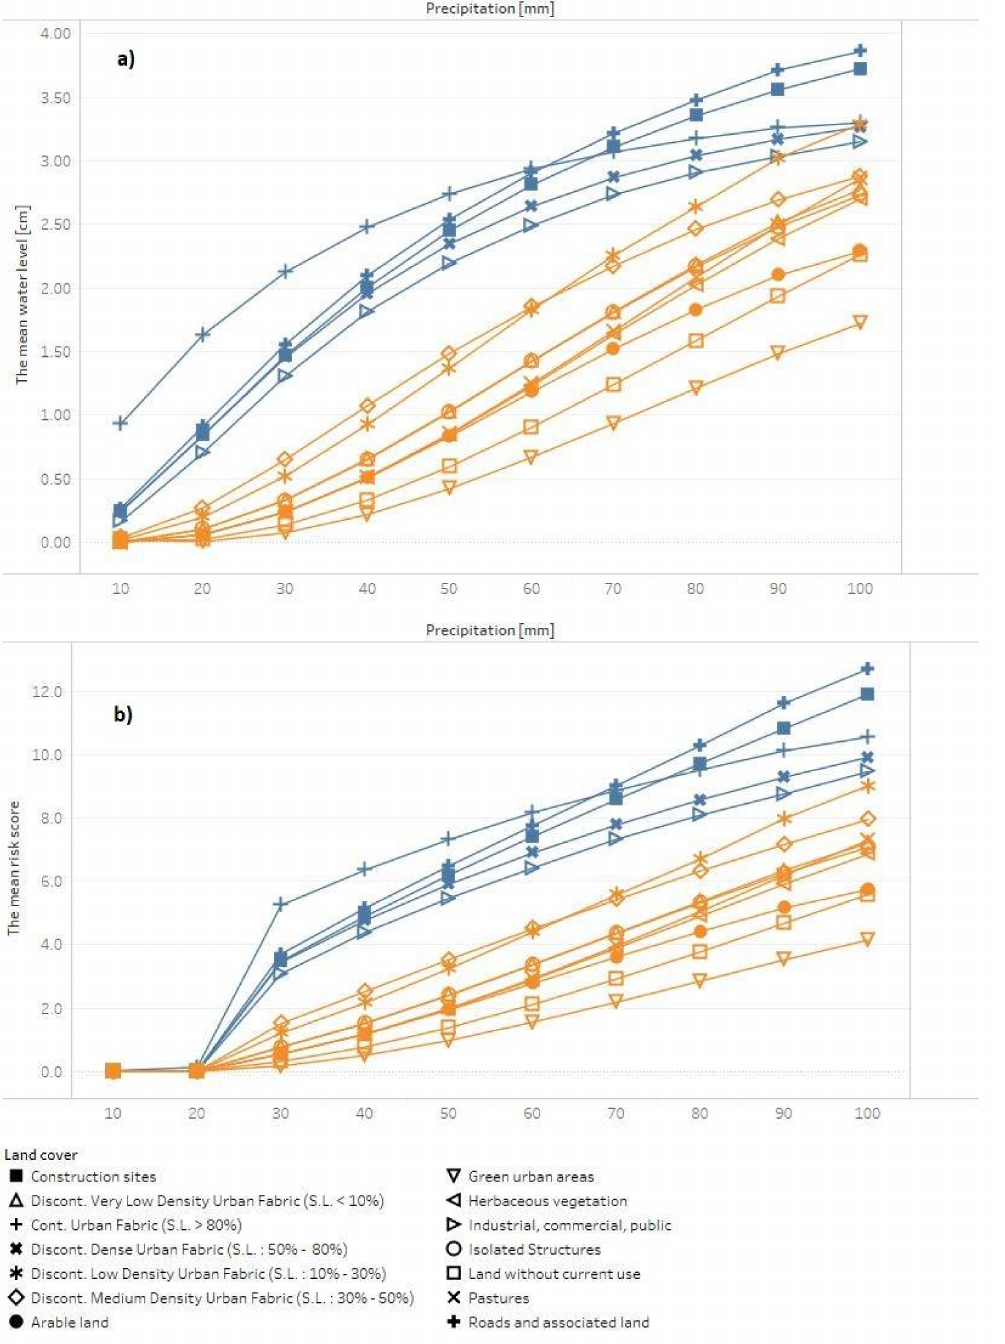
Figure 3. ( a ) The mean water level [cm] and ( b ) the mean risk score in different land cover classes according to the simulated precipitation height